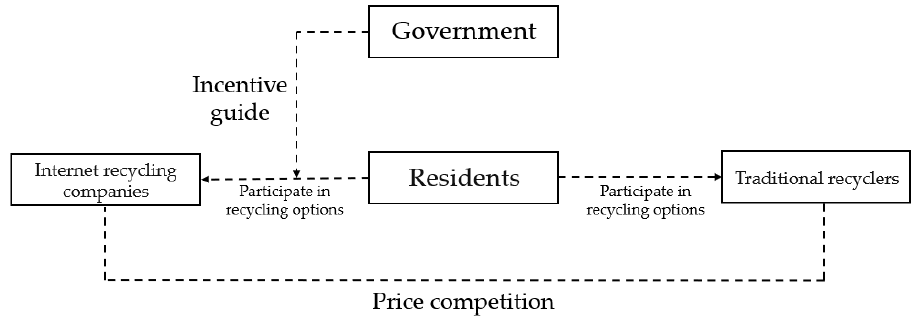
Figure 2. Relationships between stakeholders in the recycling of household appliance waste.